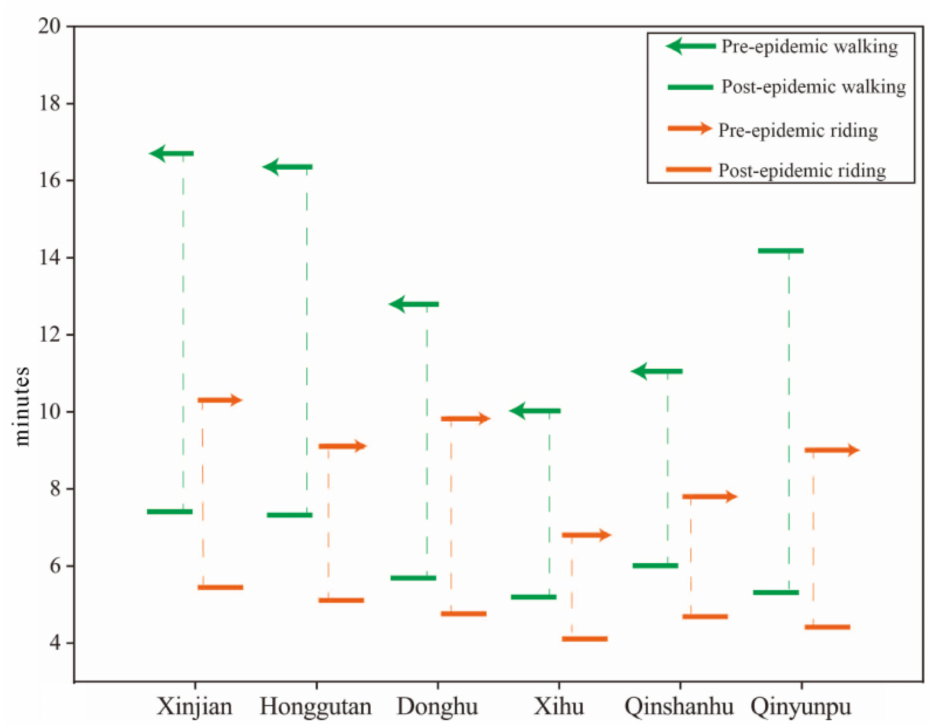
Figure 15. The average time cost of walking and riding in each district.